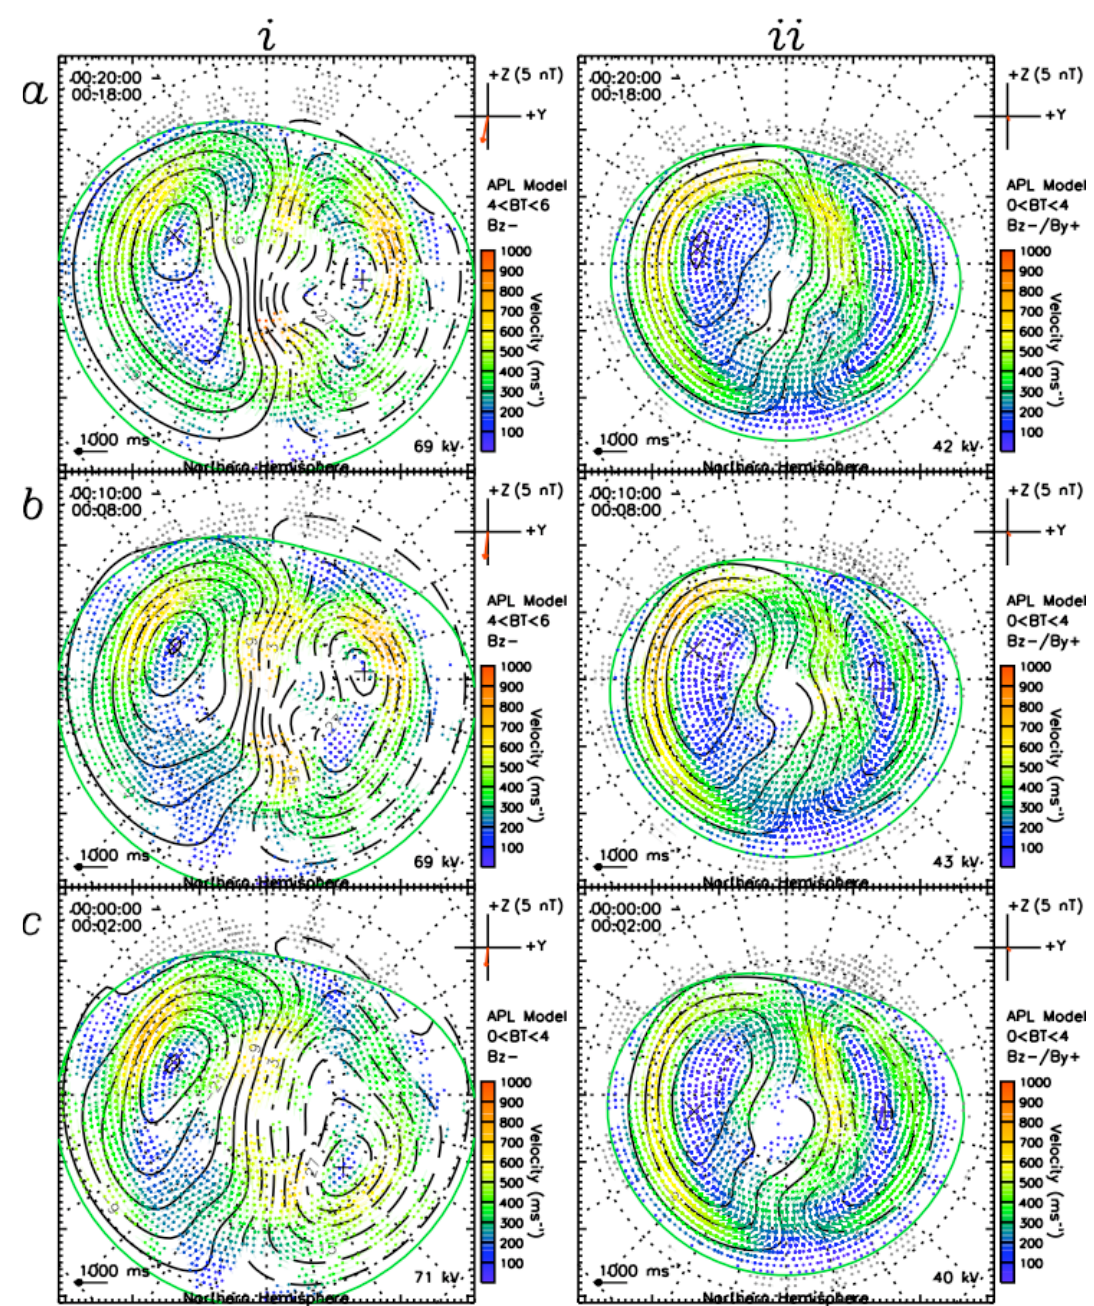
Fig. 3. Average convection patterns for the (i) 61 ◦ –62 ◦ , (ii) 68 ◦ –69 ◦ onset-latitude bins at selected times surrounding substorm onset, presented in magnetic latitude – magnetic local time coordinates with noon to the top and dusk to the left. The equipotential contours represent the plasma streamlines of the fitted convection pattern, with vectors showing the fitted velocity at the locations of the radar measurements. The velocity vectors are colour coded according to the scale shown along side each